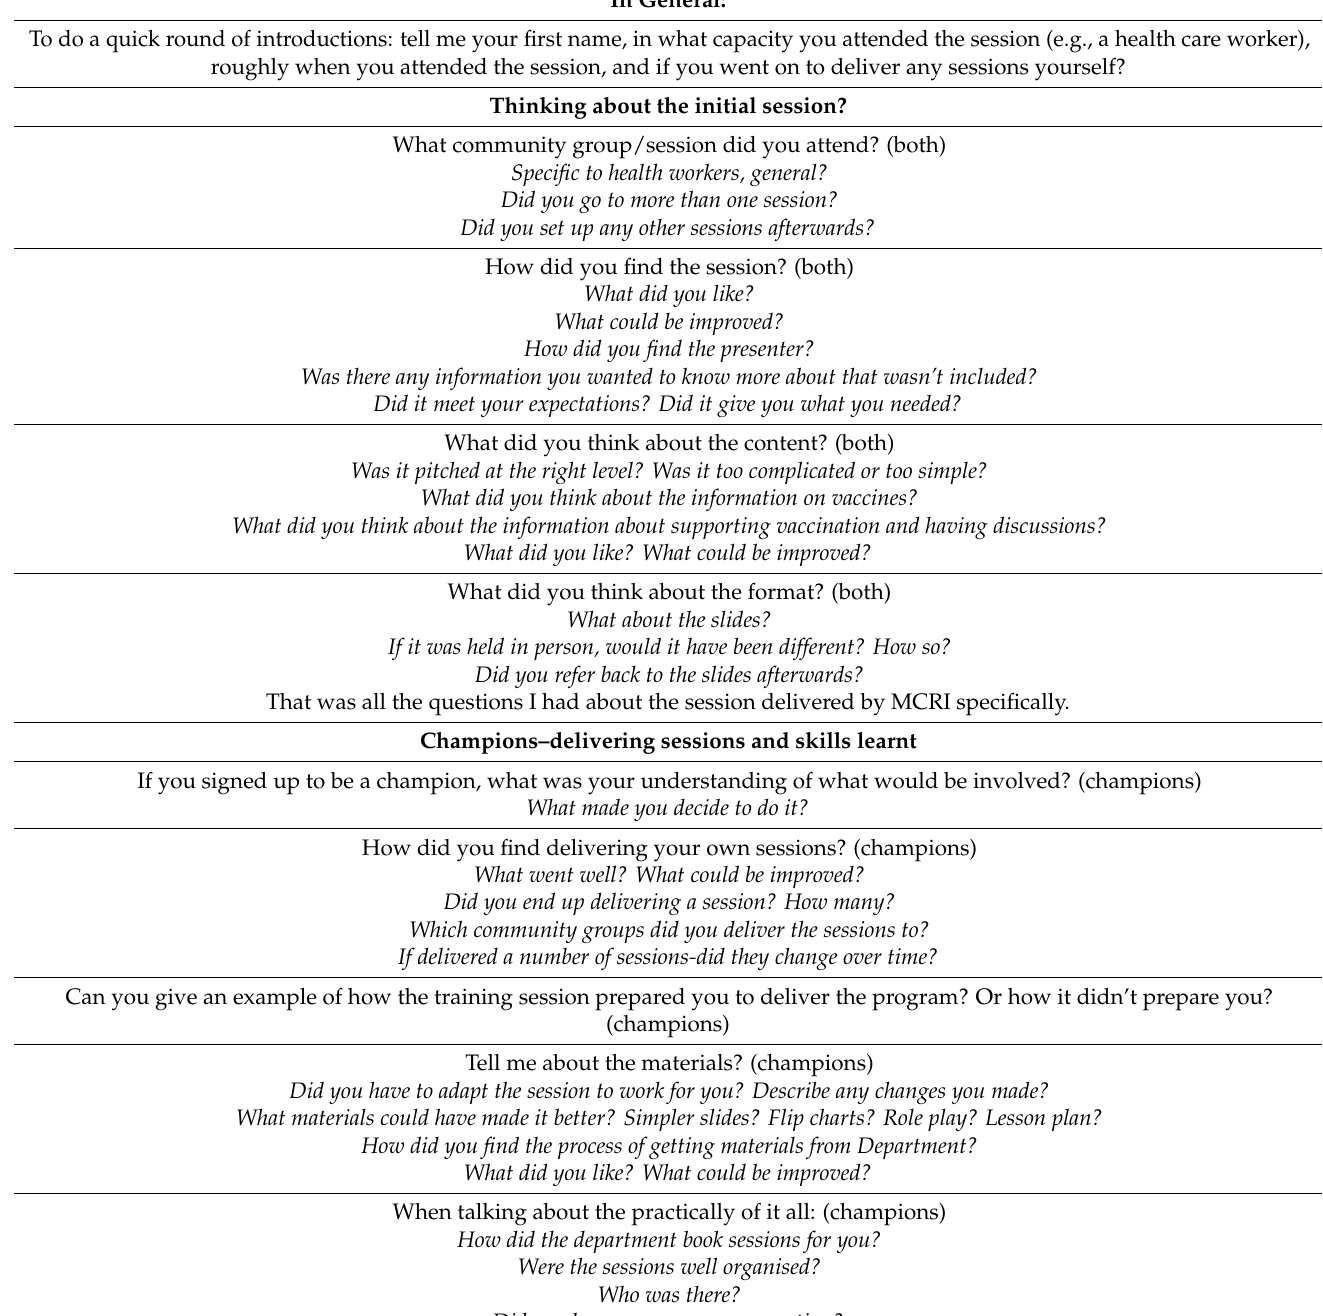
Table A2. Group Interview Guide (Vaccine Champions or Attendees). Prior to interview commence- ment: Acknowledgement of country; Study explanation, housekeeping; Consent. In